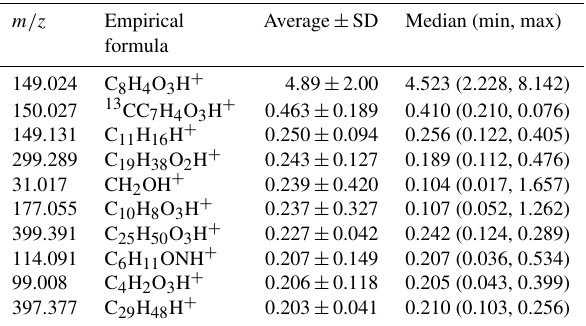
Table 4. The 10 highest EFs (mgkg − 1 of fuel) for LDVs.